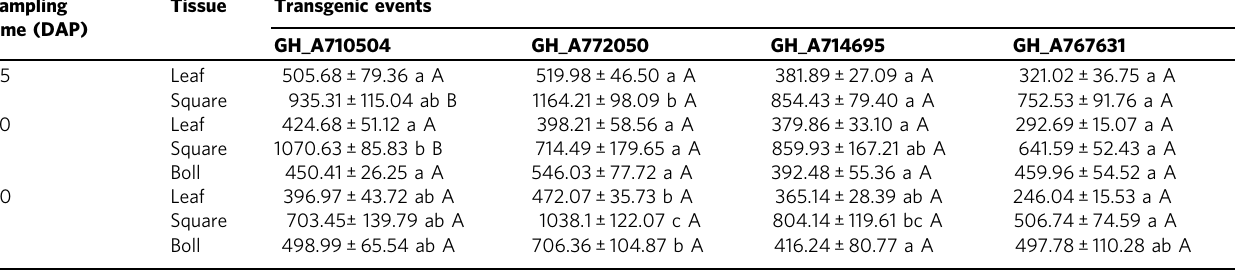
Table 2 . Cry51Aa2.834_16 accumulation ( µ g g − 1 dry weight) in various tissues of transgenic cotton